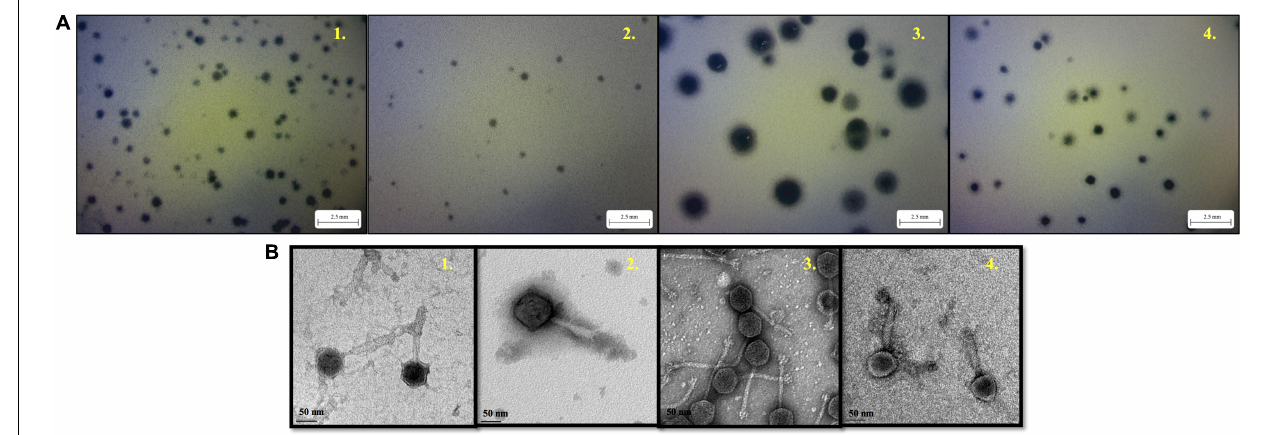
FIGURE 1 | The morphology of plaques formed by phage vB_EcoM-Ro111lw (A1) , phage vB_EcoM-Ro121lw (A2) , phage vB_EcoS-Ro145lw (A3), and phage vB_EcoM-Ro157lw (A4) on their host strains of STEC O111, O121, O145, and O157, respectively, using plaque assay, and the transmission electron microscopy images of phage vB_EcoM-Ro111lw (B1) , phage vB_EcoM-Ro121lw (B2) , phage vB_EcoS-Ro145lw (B3) , and phage vB_EcoM-Ro157lw (B4) .